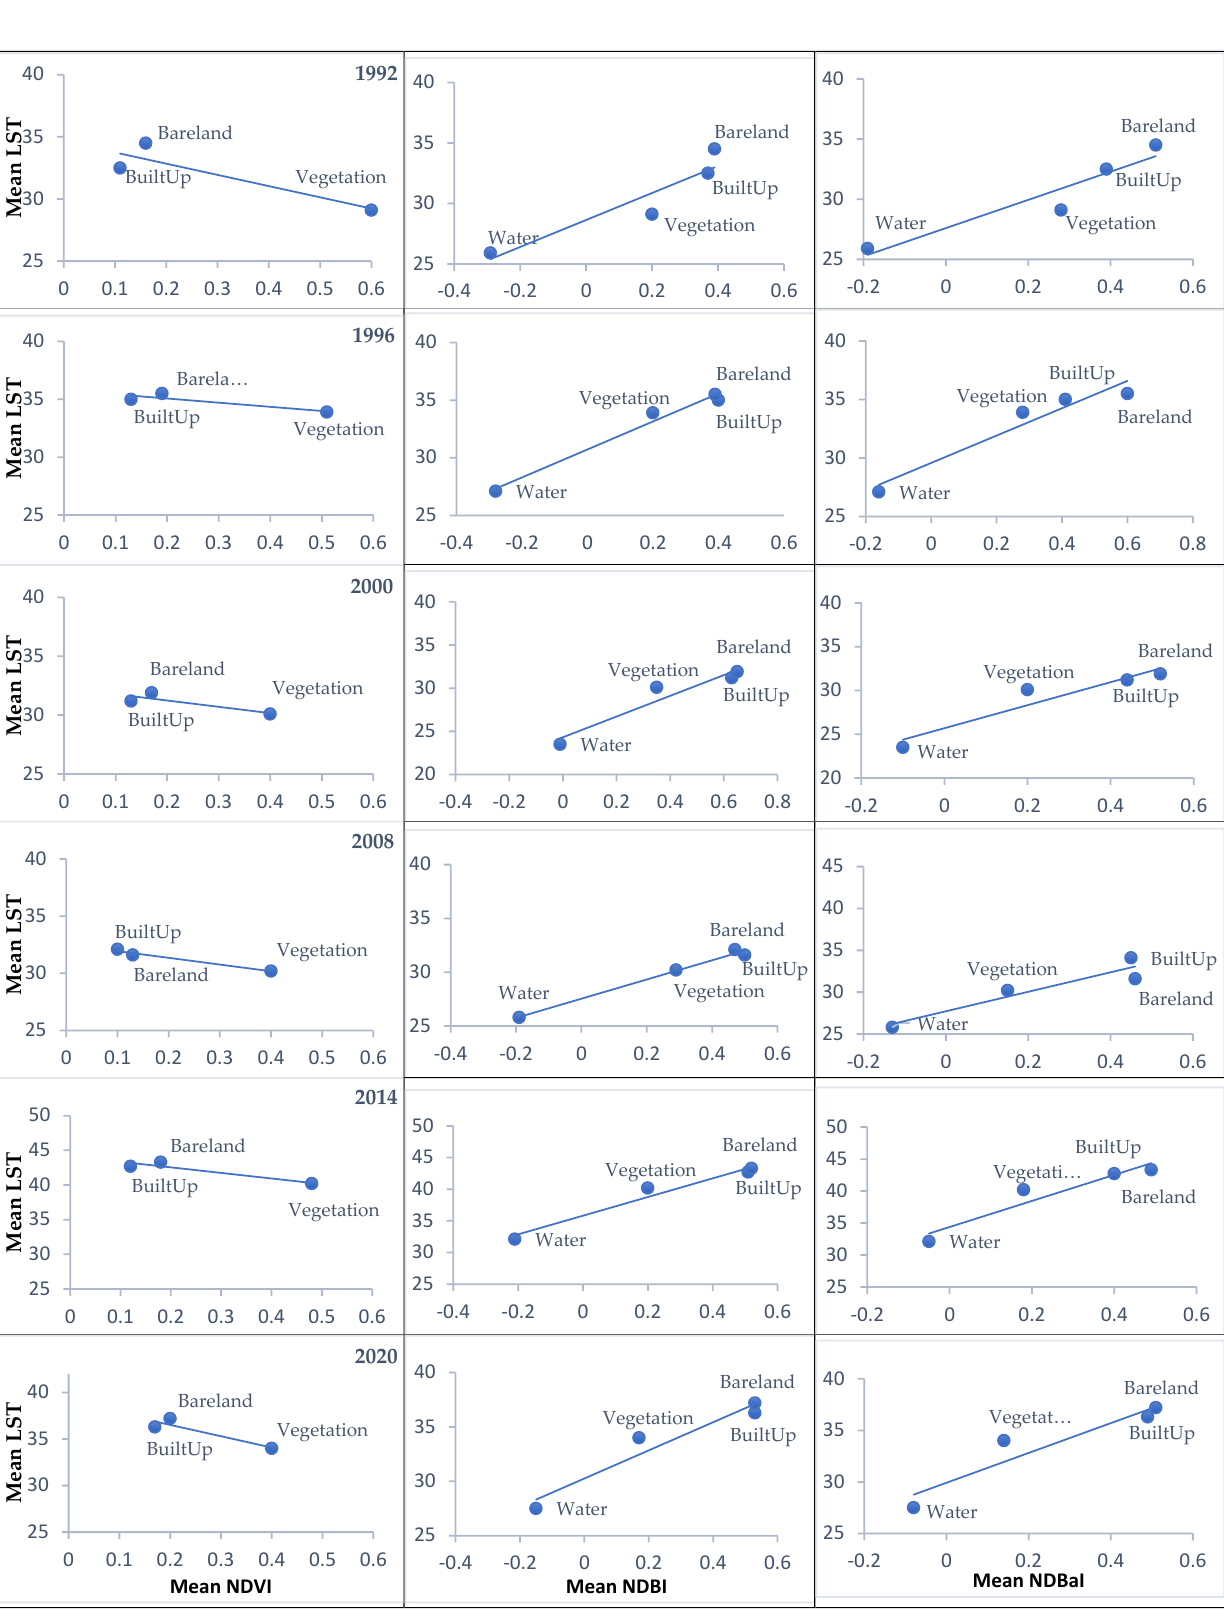
Figure 8. Scatterplots of mean NDVI, NDBI and NDBaI values vs. LST in association with LULC from 1992 to 2020. Each point is the mean value obtained for each index, and LST in association with LULC classes.